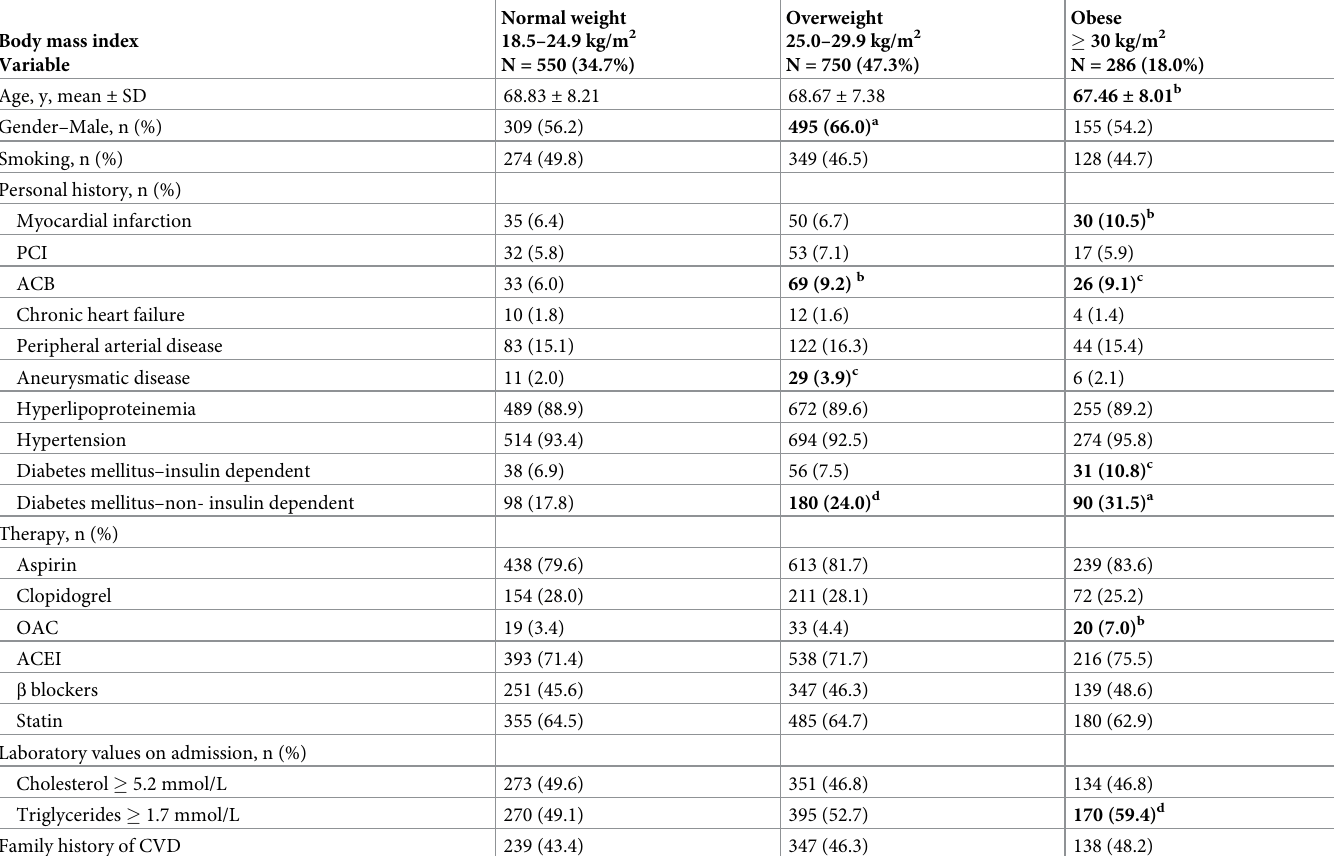
Table 1. Demographic characteristics, smoking, personal history, therapy, laboratory values on admission and family history of cardiovascular diseases, by body mass index �